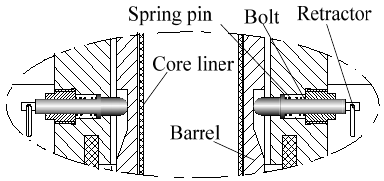
Figure 5. Structure of the four springs bolts hooking the barrels.